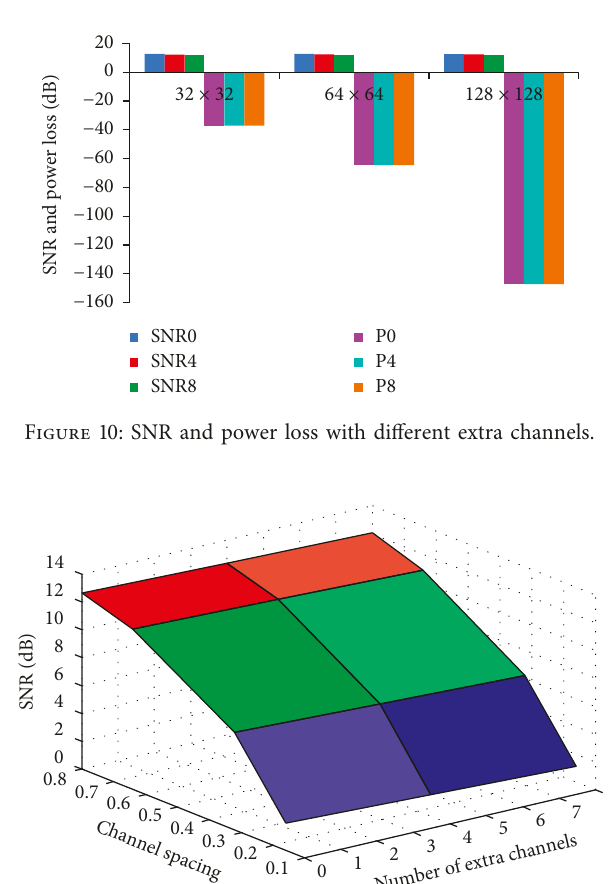
Figure 9: SNR and power loss with different redundant rings.